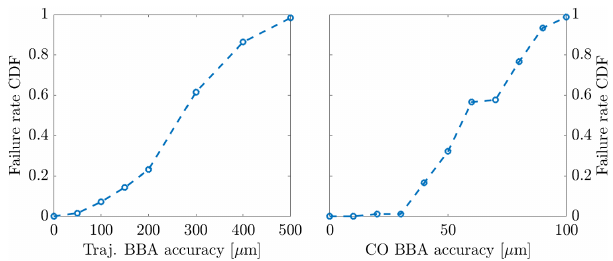
FIG. 6. Correction chain failure rate vs assumed accuracy of the trajectory (left) and closed-orbit BBA (right). For trajectory, BBA failure is defined as not achieving 1000 turns beam transmission after rf commissioning; for closed-orbit BBA as nonconvergence of the linear-optics correction as described in Sec. IV